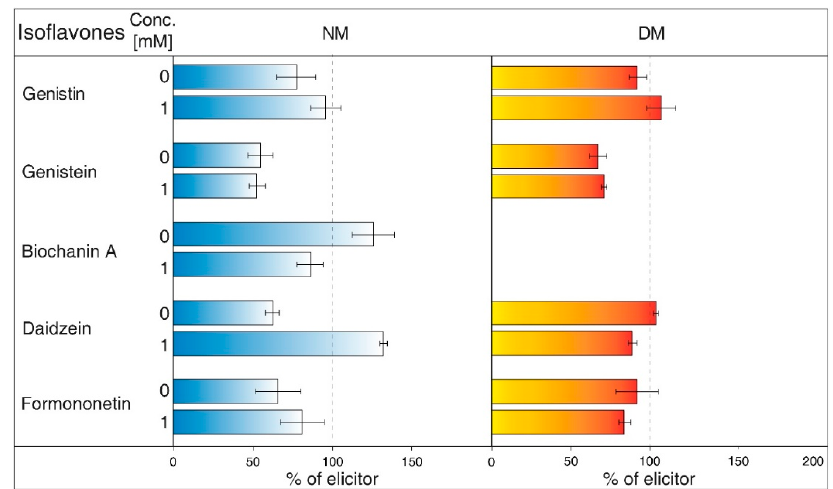
Figure 6. Effects of verapamil on isoflavone content in nutrient medium (NM) and dry matter (DM) of Genista tinctoria cell culture. Zero concentration of inhibitor represents water control. All bar values were recalculated to a relative 100% isoflavone content in samples with NH 4 VO 3 (1 μ M) after 24 h. Data are mean of three repeats ± SE.